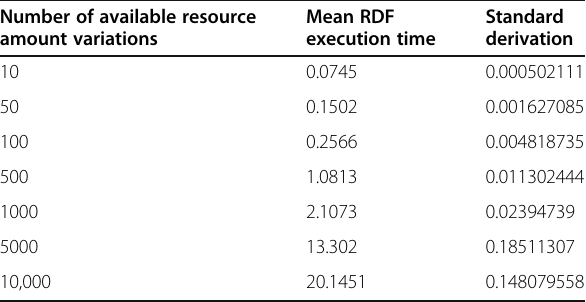
Table 8 Analysis of RDF execution time for different numbers of resource amount variations Number of available resource amount